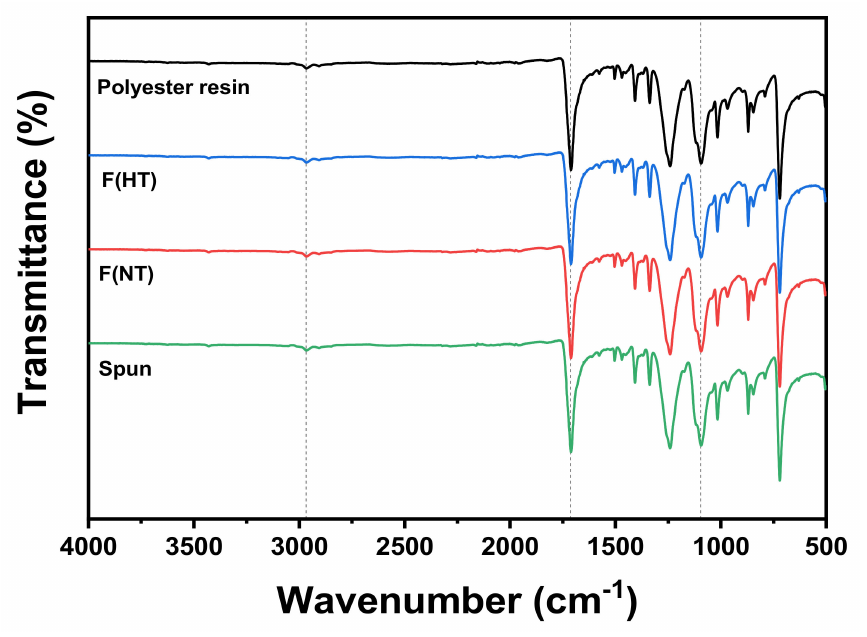
Figure 1. FTIR spectroscopy of polyester resin and three different fabrics classified by yarn types.